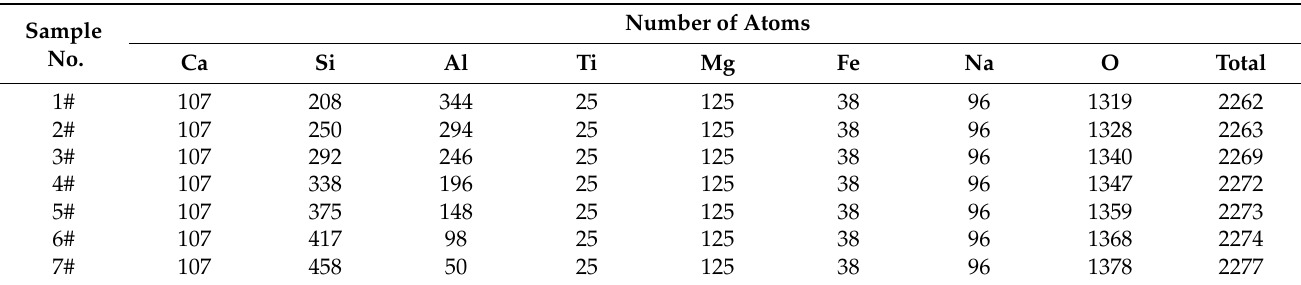
Table 3. Number of atoms in molecular dynamics.